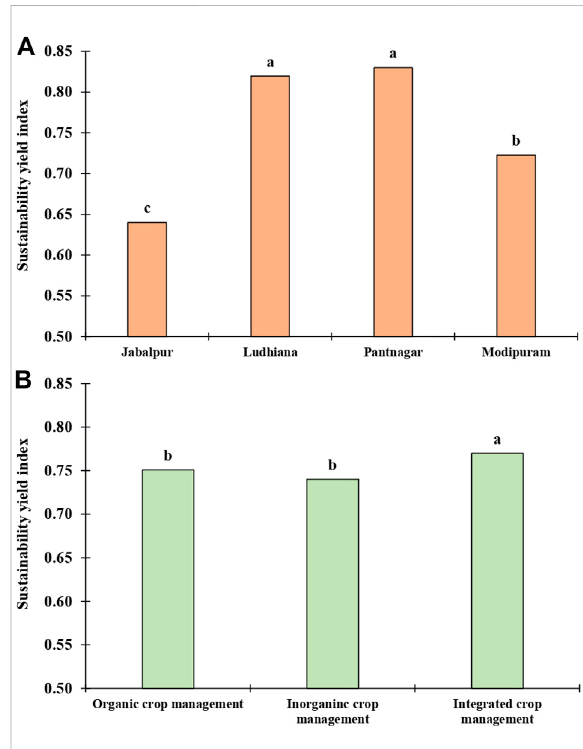
FIGURE 3 Sustainability yield index in fl uenced by (A) spatial variation and (B) crop management in the rice – wheat system. Different lowercase letters in the same color columns (for each factor) are signi fi cantly different at p <